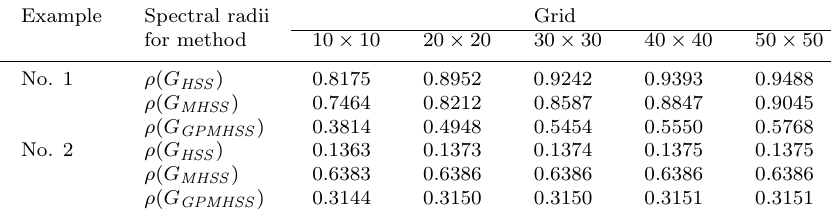
Table 2. The comparison of ρ ( G HSS ), ρ ( G MHSS ), and ρ ( G GPMHSS ).